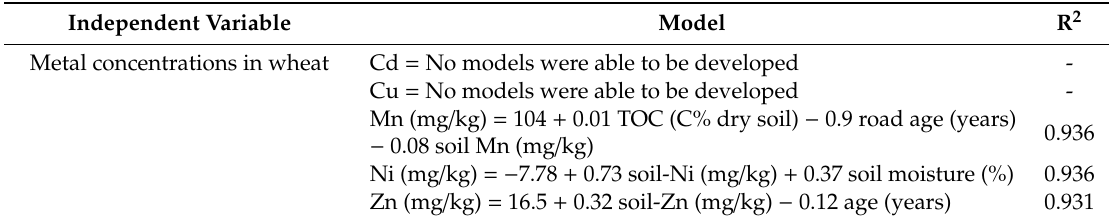
Table 4. Optimised linear models for the relationship between metal concentration in wheat, and soil chemical and physical properties. Models were determined by stepwise regression using list wise forward selection (criteria of α = 0.05 for